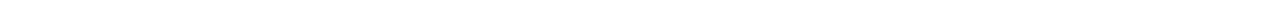
Fig. 3 T2iLGö hiNPSCs metabolic pro fi le is closely related to preimplantation epiblast. a Genes coding proteins of the electron transport chain, located in the inner membrane of the mitochondria, are upregulated in human epiblast cells and T2iLGö hiNPSCs in comparison to their primed counterparts. Relative expression of genes related to oxidative phosphorylation pathway for hESC, morula and epiblast samples analyzed by single-cell RNA-seq (left), and analyzed by DGE-seq for primed or naive hPSCs (right). Genes were classi fi ed by mitochondrion complex and hierarchically clustered. b T2iLGö hiNPSCs have higher metabolic activity than their isogenic counterparts in RSeT and KSR+FGF2. A SeaHorse apparatus was used to measure the oxygen consumption rate and the extracellular acidi fi cation rate of hiNPSC and hiPSC lines, maintained in indicated culture conditions. This fi gure presents six biological replicates. Each symbol in the panel is the average of a technical triplicate. c T2iLGö hiNPSCs have a higher resistance to inhibition of glycolysis. Quanti fi cation of colony numbers obtained after culture with the indicated concentrations of 2-deoxy-D-glucose. Primed cells were seeded in StemMACS ™ iPS Brew XF, and naive cells were seeded in the indicated medium. Error bars indicate s.d. of three technical replicates. The presented experiment is representative of four independent